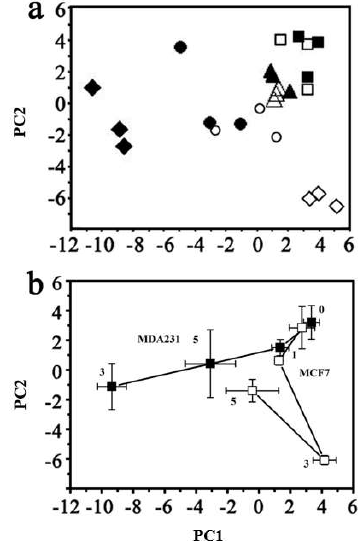
Figure 2. The overall metabolic response to ADR damage visualized using ( a ) principal component analysis (PCA) of all cell samples (R 2 = 0.547 and Q 2 = 0.367). MDA-MB-231 cells with ADR treatment for: ■ 0 days; ▲ 1 day; ◆ 3 days; ● 5 days. MCF7 cells with ADR treatment for: □ 0 days; △ 1 day; ◇ 3 days; ○ 5 days. ( b ) The centroided metabolic trajectories for the two cell lines during ADR treatment: ■ MDA-MB-231; □ MCF7. PC1 loading: 36.3%; PC2 loading: 18.4%. Table 1. Metabolites showing significantly altered levels during cell senescence in the MCF7 cell line and their related metabolic pathways. MCF7 Cells MCF7 Cells 3 Day versus 0 Day 5 Day versus 3 Day 3 Day Versus 0 Day 5 Day Versus 3 Day Involved Pathway Metabolite Fold Change p